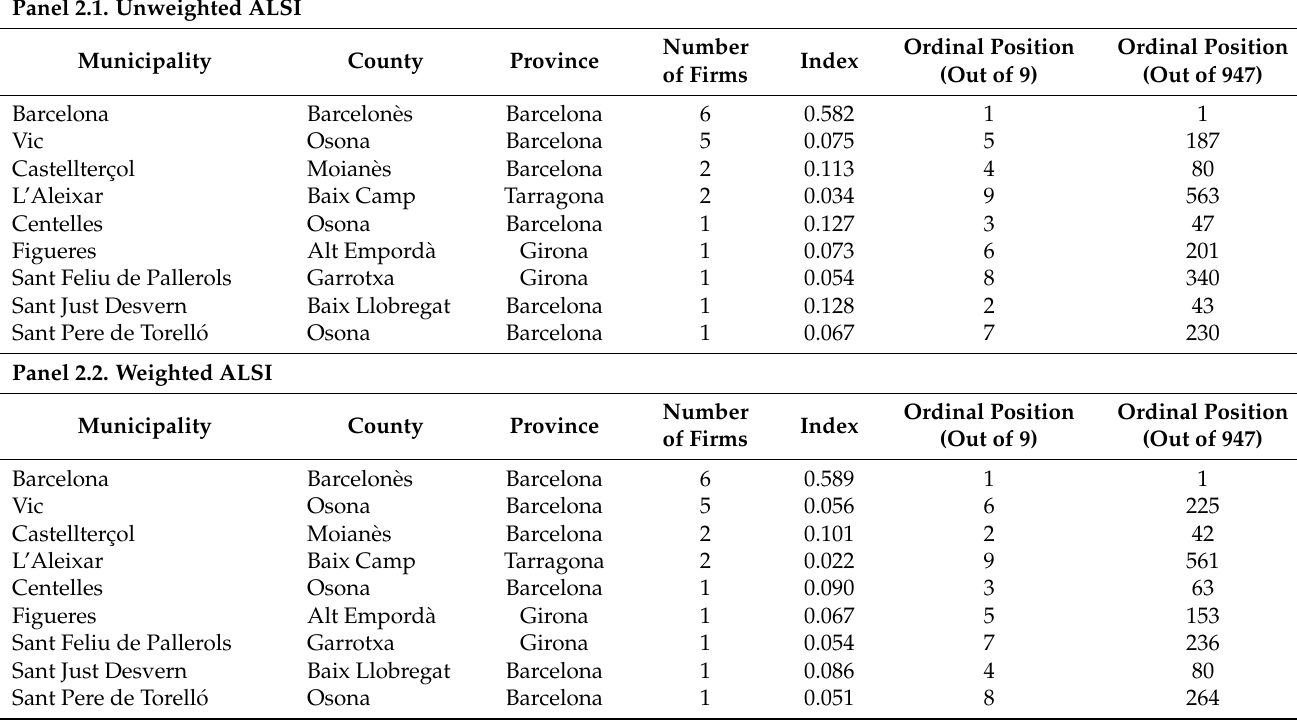
Table 2. The Apparent Location Suitability Index (ALSI) in the municipalities of Catalonia with meat processing firms in